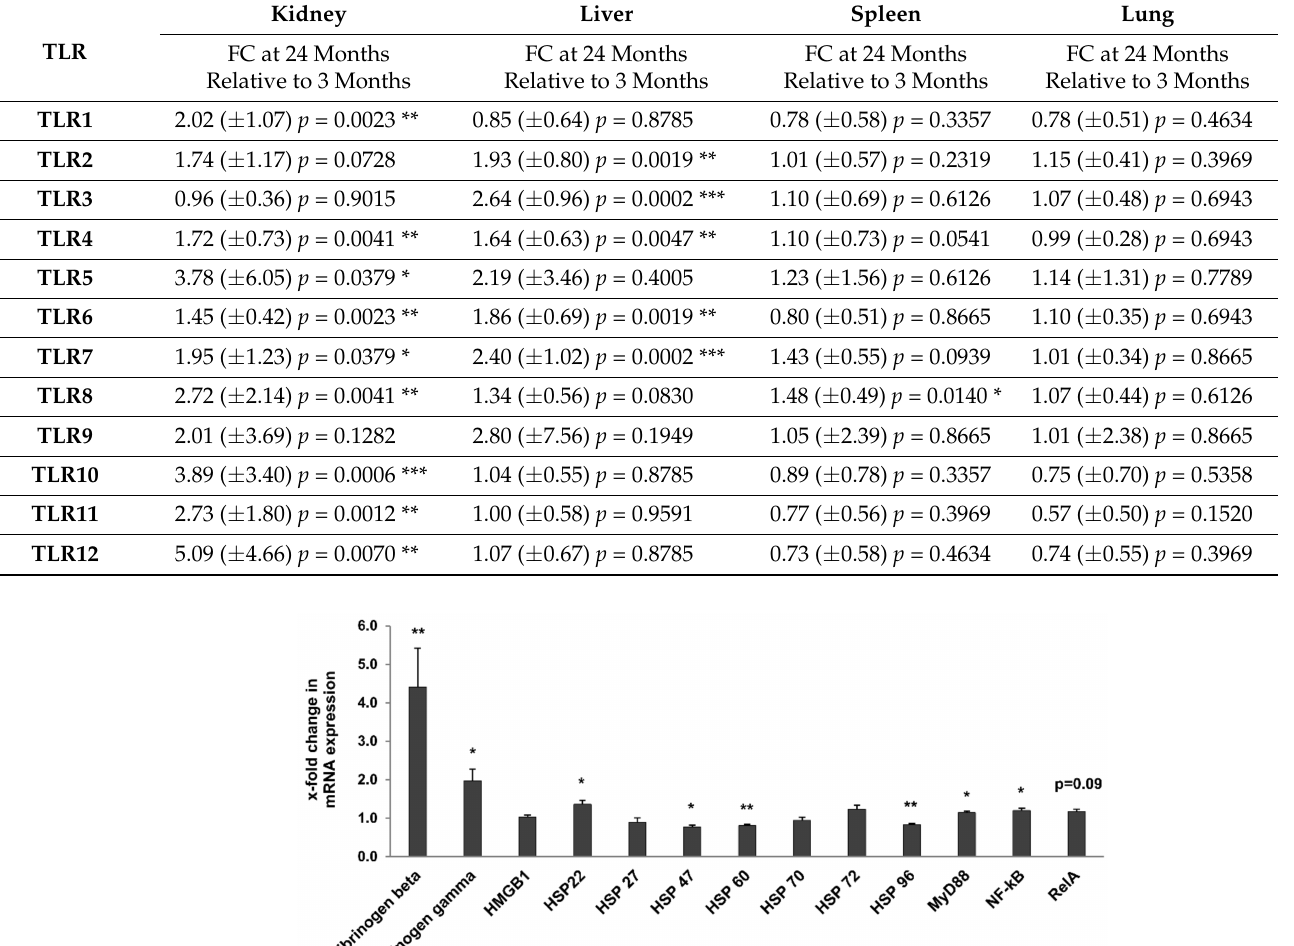
Table 2. Expression of TLR1–12 in kidney, liver, spleen and lung of 24-month-old rats expressed as fold change relative to 3-month-old rats. p -values ≤ 0.05, ≤ 0.01, and ≤ 0.001 are indicated by one, two or three asterisks, respectively.